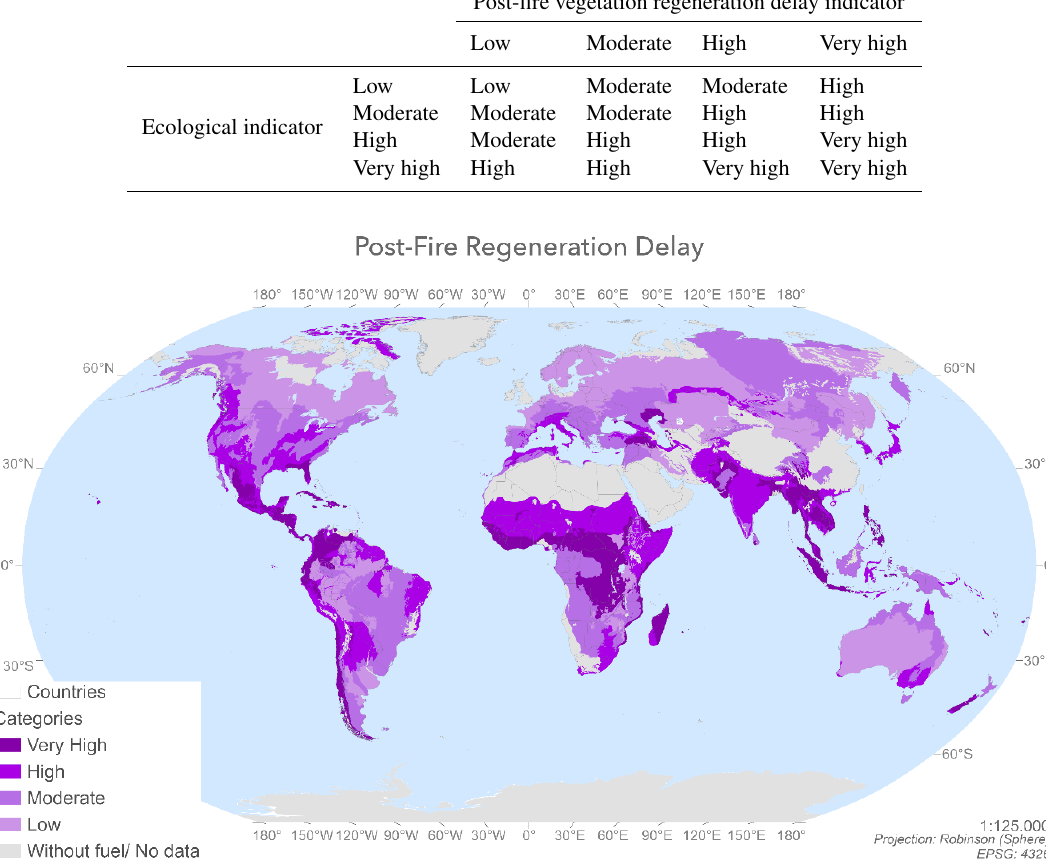
Figure 2. Spatial distribution of post-fire regeneration delay values by ecoregion calculated by combining the adaptation to fire and the potential soil erosion values by